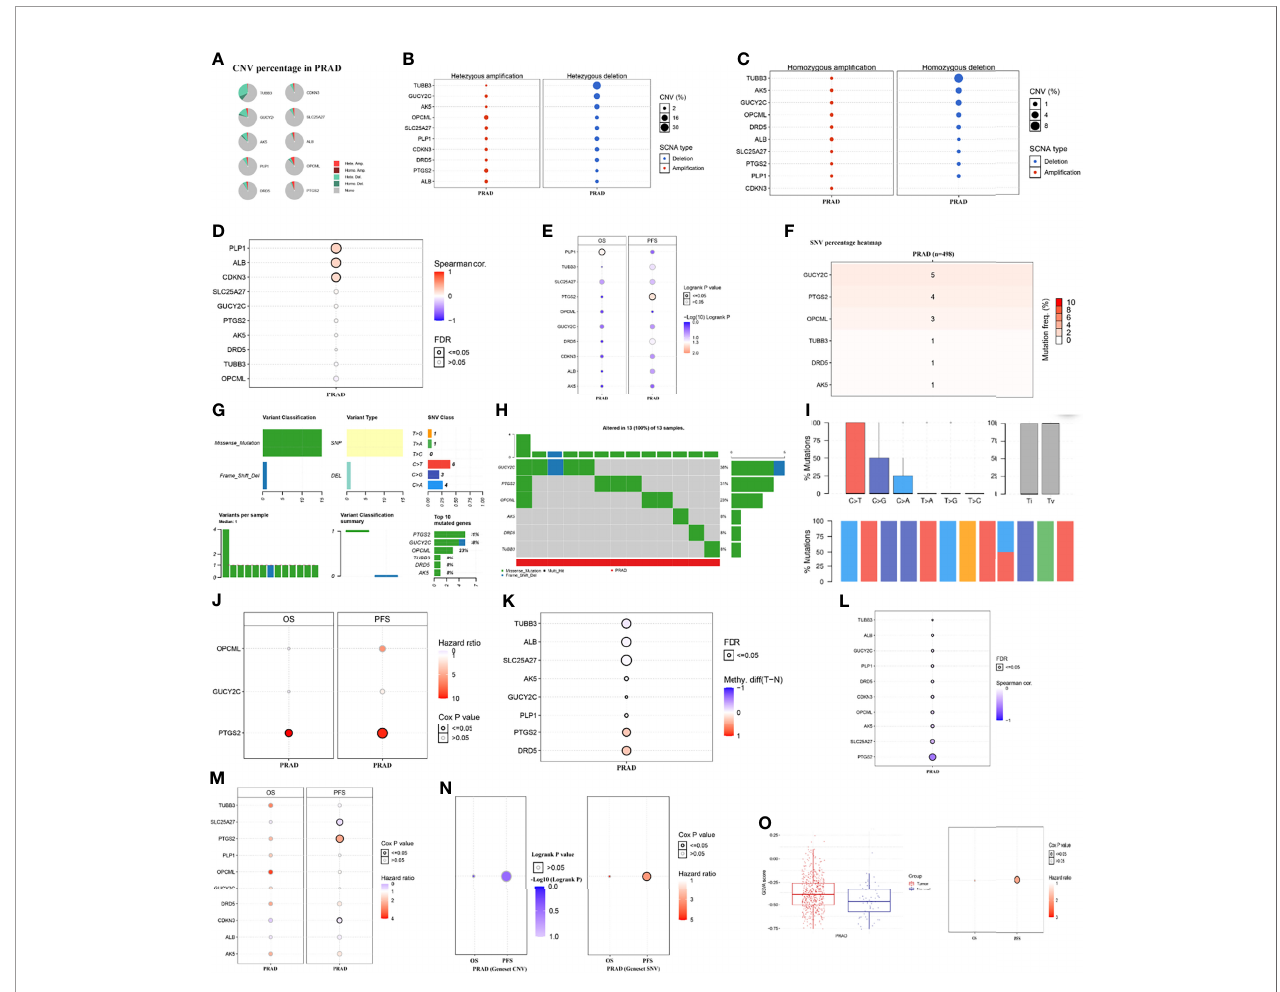
FIGURE 6 | The mutation situation of genes and its correlation with overall survival and progress free survival in PCA patients at the levels of copy number variation, single nucleotide variation, and methylation from GSCALite (35). (A) CNV percentage in PCA patients; (B) the pro fi le of heterozygous CNV of genes; (C) the pro fi le of homozygous CNV of genes; (D) the correlations between CNV and mRNA expression; (E) the difference of survival between CNV and wide type; (F) SNV percentage heatmap; (G) SNV classes; (H) oncoplot providing the situation of the SNV of mutated genes; (I) the Transitions and transversions classi fi cation of the SNV of inputted gene set; (J) the survival difference between mutant (deleterious) and wide type; (K) the methylation difference between tumor and normal samples of inputted genes; (L) the pro fi le of correlations between methylation and mRNA expression of inputted genes; (M) the overall survival difference between higher and lower methylation groups; (N) the survival difference between WT and gene set CNV and SNV; (O) the GSVA score of gene set in tumor samples and normal samples and its difference in OS and PFS. CNV, copy number variation; SNV, single nucleotide variation; OS, overall survival; PFS, progress free survival; FDR, false discovery